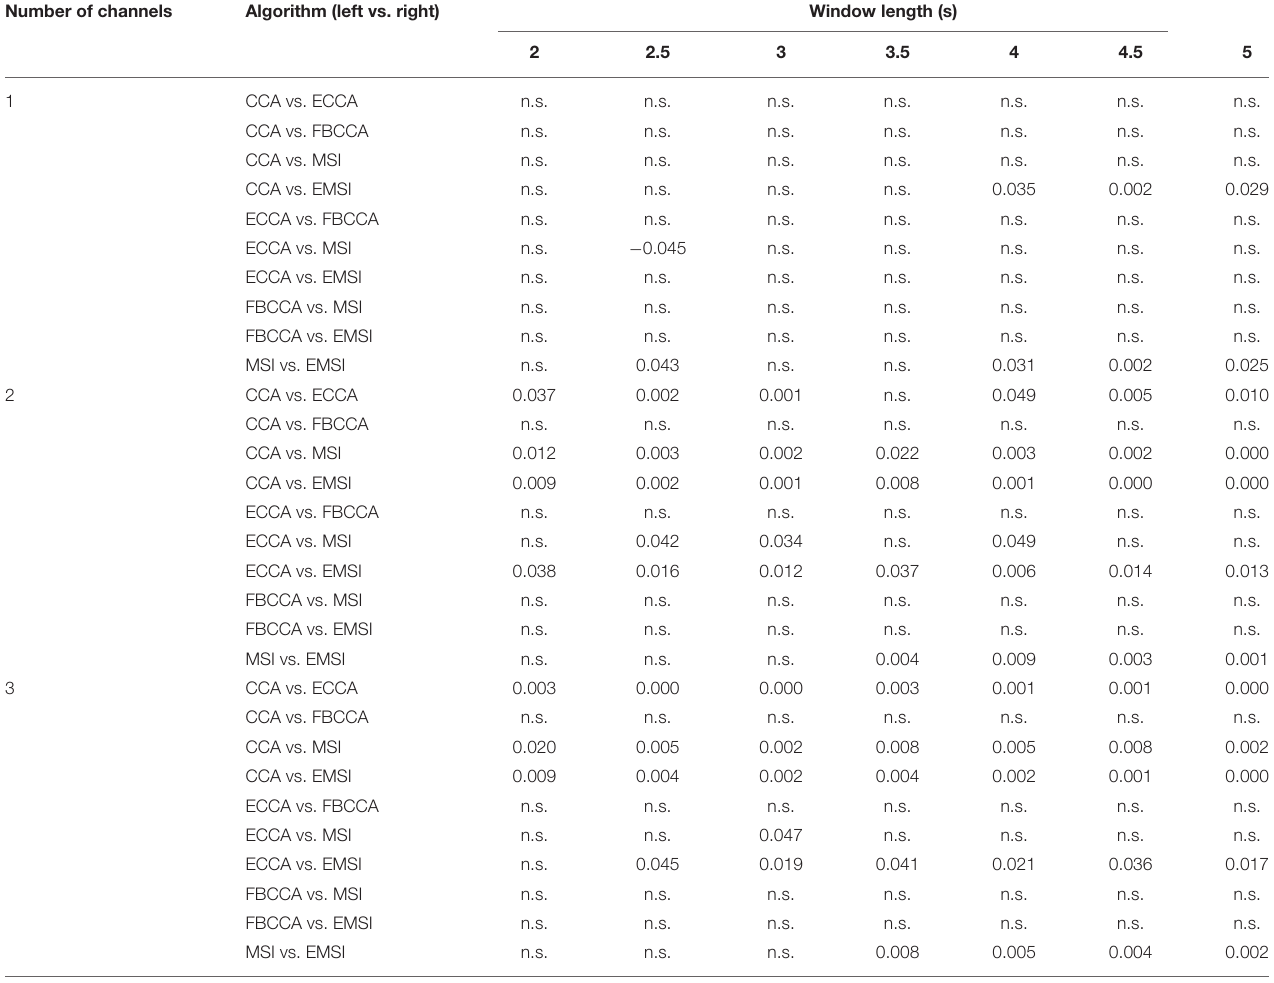
TABLE 3 | Bonferroni corrected p -values of post-hoc analysis among the average classification accuracies across the electrode shift (ACA)s in five different algorithms for the number of channels and window length. Number of channels Algorithm (left vs.